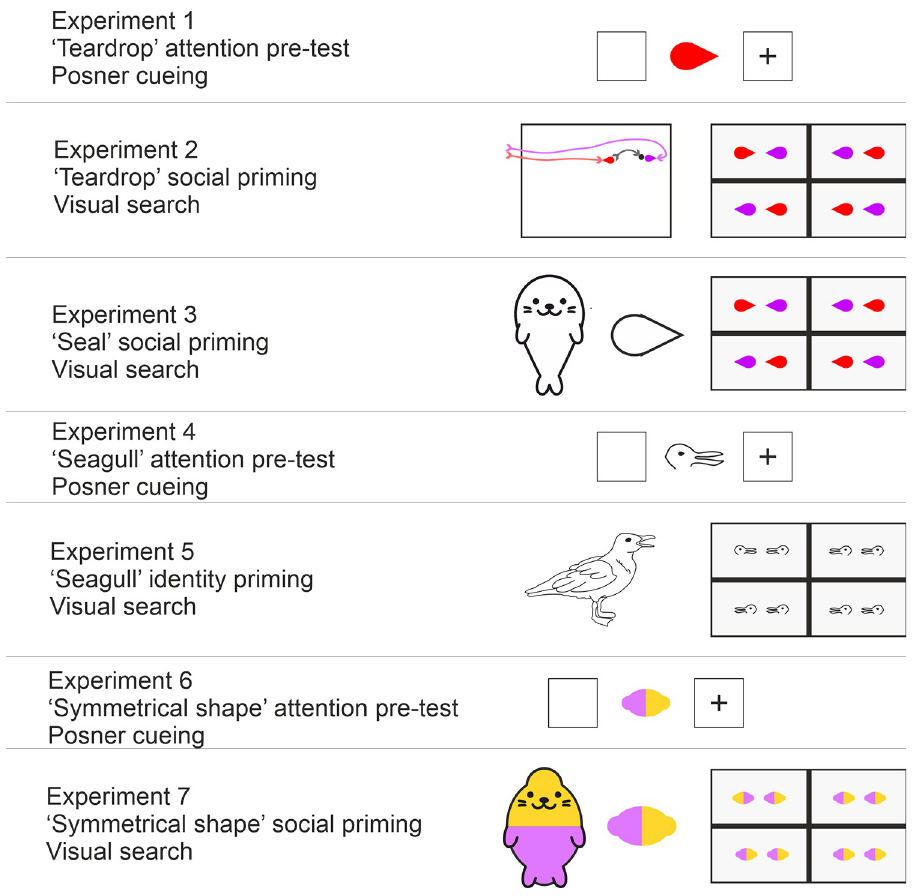
Fig 4. Representations of each experiment with associated